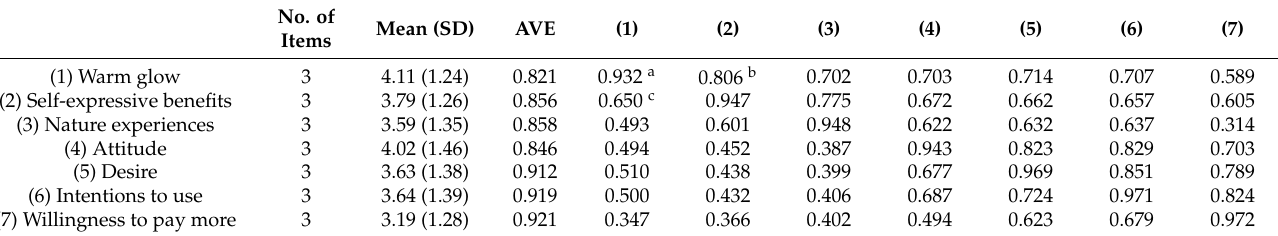
Table 3. Descriptive statistics and associated